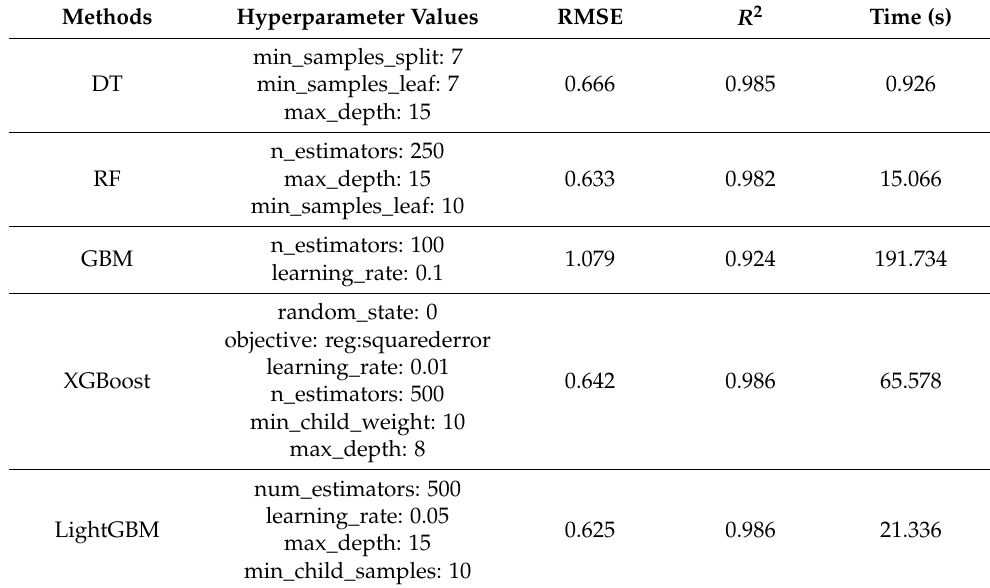
Table 8. Root Mean Square Error (RMSE) and R-square